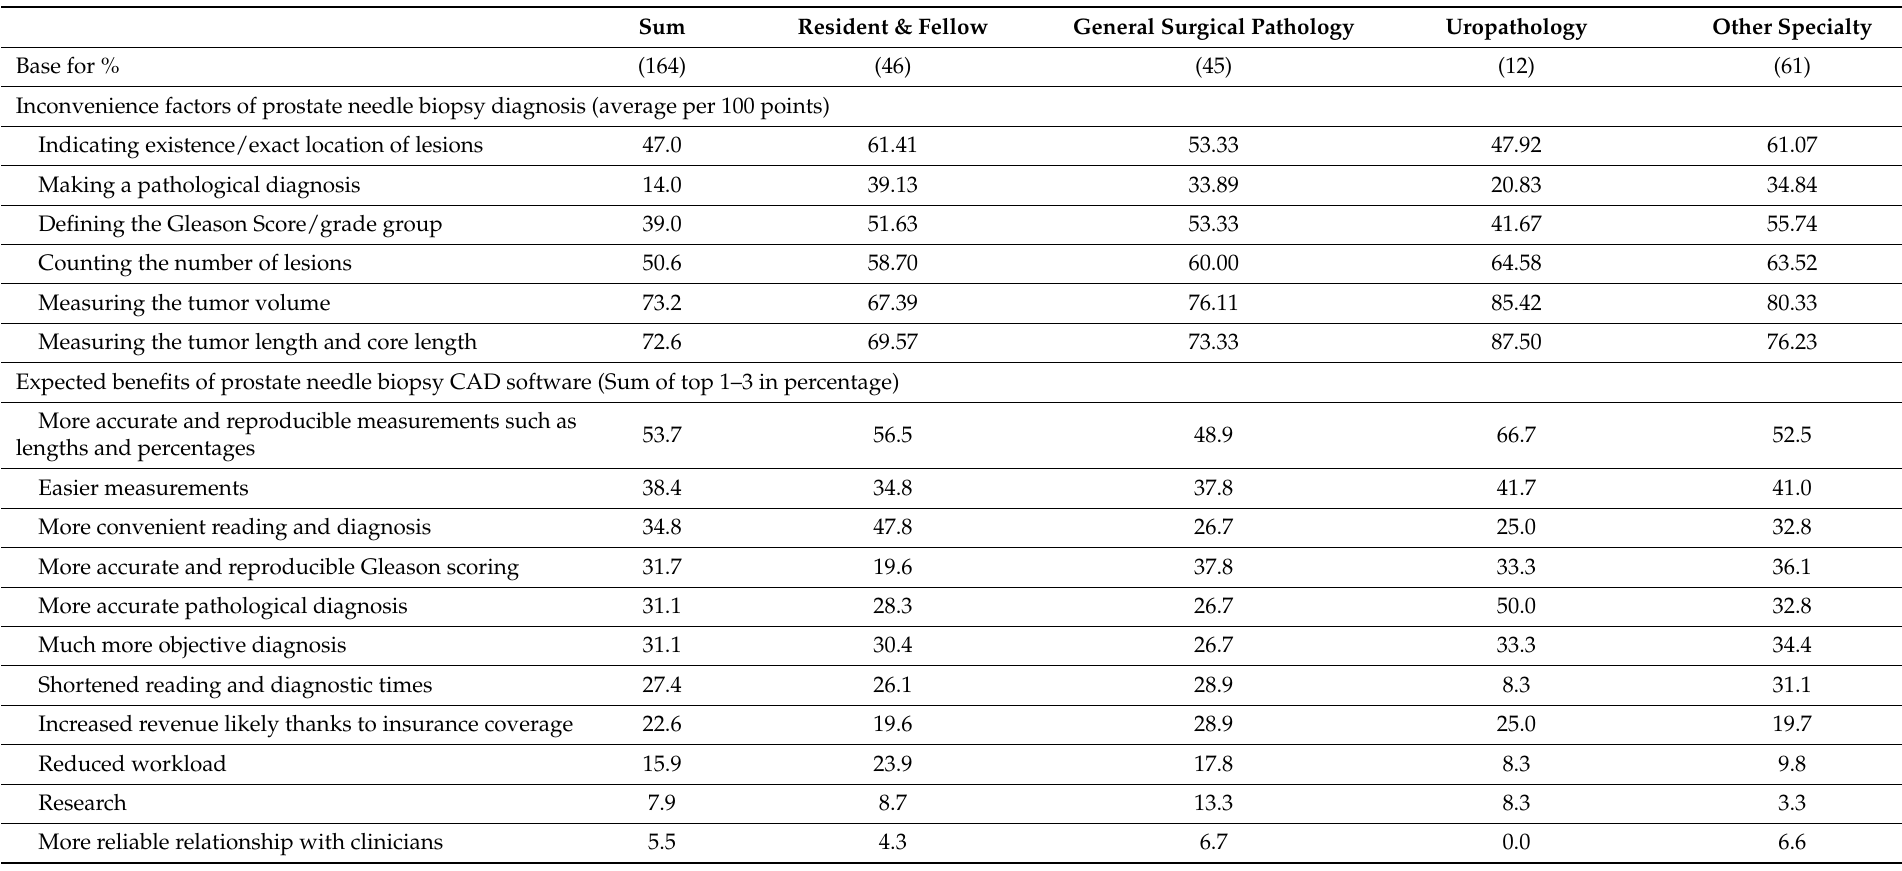
Table 3. The inconvenience of prostate needle biopsy diagnosis and the expected benefits of prostate needle biopsy CAD software by